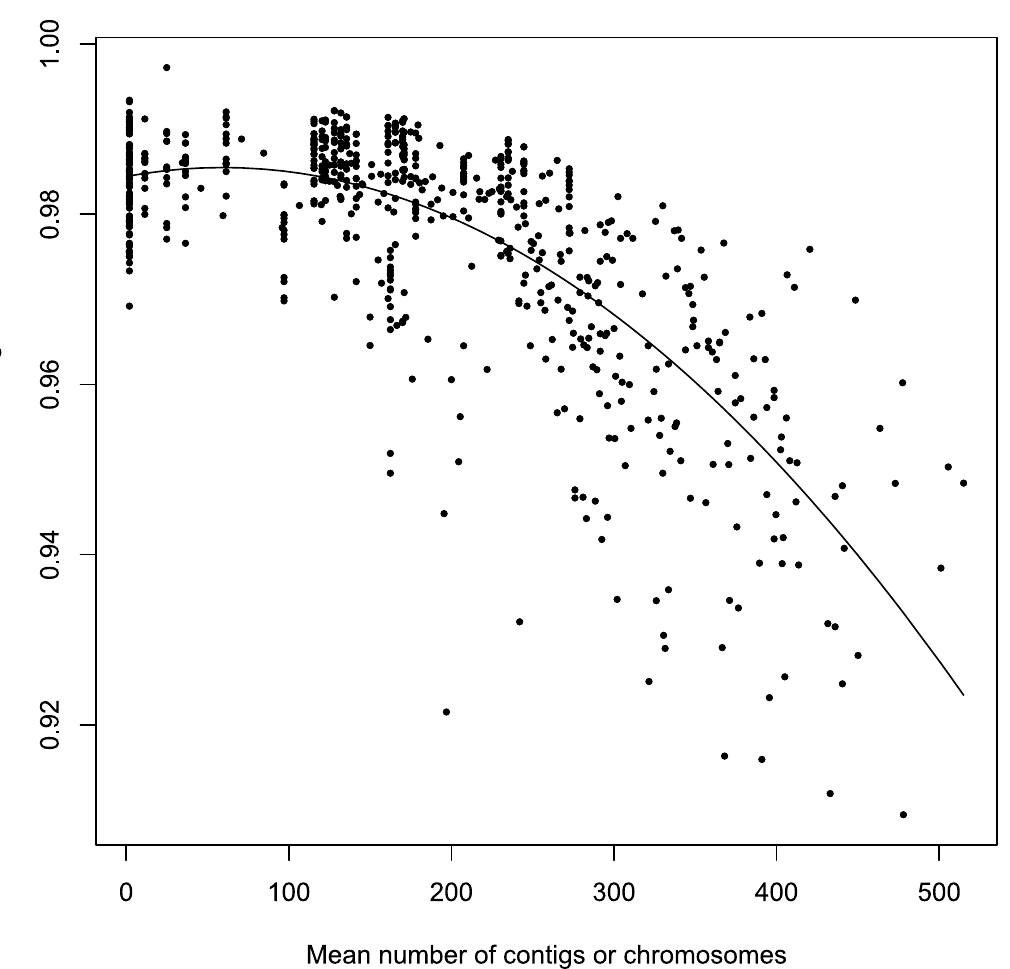
Fig 9. Influence of number of contigs on gene order conservation. Number of contigs is the mean number of contigs of the pair of isolates. Fitted line is y = 0.9844+3.5×10 − 5 x − 3.0×10 − 7 x 2